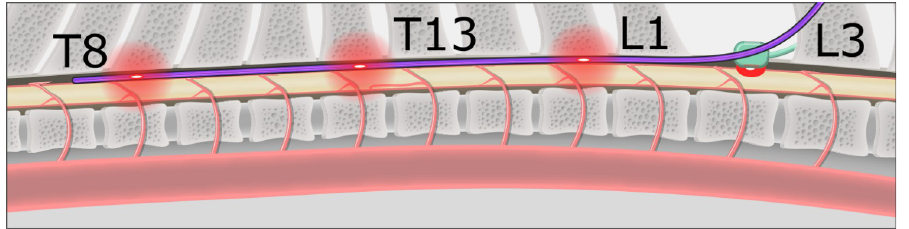
Fig 2. Schematic of pig spine with FLOXsp (blue) and LDF probes (green) in place. The REOBA balloon is shown in 5 positions, above/below each of the cephalad, central, and caudal DCS measurement sites (in this example, T9, T12, and T15), as well as the LDF site at the L2 laminotomy. Red clouds indicate the approximate zone of illumination for each